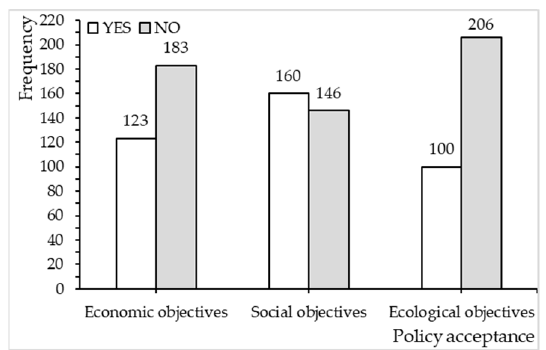
Figure 1. Residents’ policy acceptance of the economic–social–ecological objectives of CLR. Source: authors’ own work.